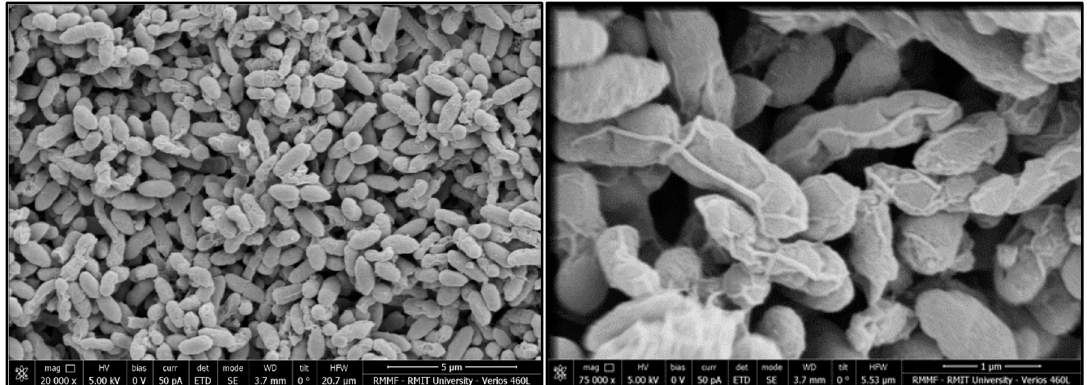
Figure 2. Scanning electron micrographs of strain ZA_0188 T showing cell morphology. Bars 5 µm ( left ) and 1 µm ( right ).